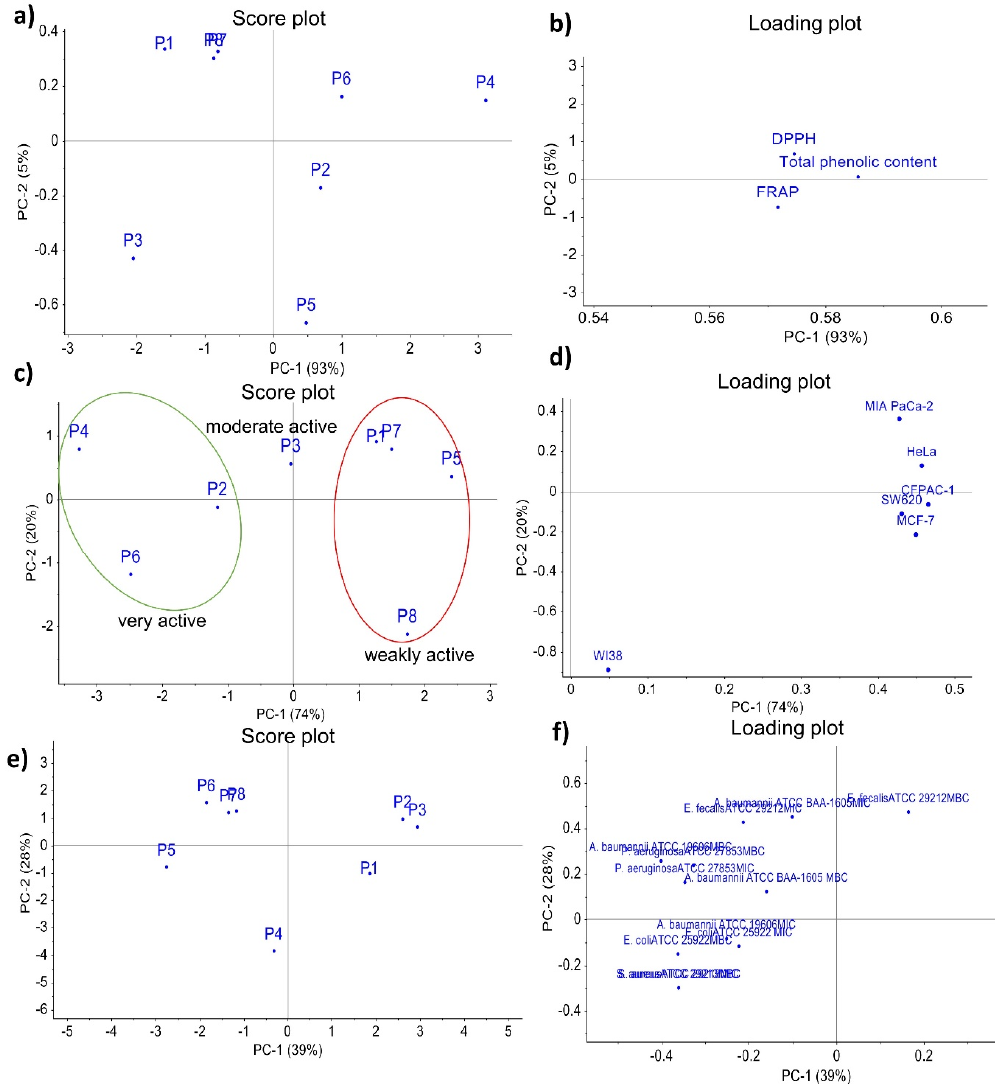
Figure 1. Principal component analysis (PCA) applied to different biological activities of eight pomegranate peel extracts obtained from samples P1–P8: ( a ) score plot and ( b ) loading plot when total phenolic content and antioxidant activity were used as variables; ( c ) score plot and ( d ) loading plot when antiproliferative activity was used as variables; ( e ) score plot and ( f ) loading plot when antimicrobial activity was used as variables.